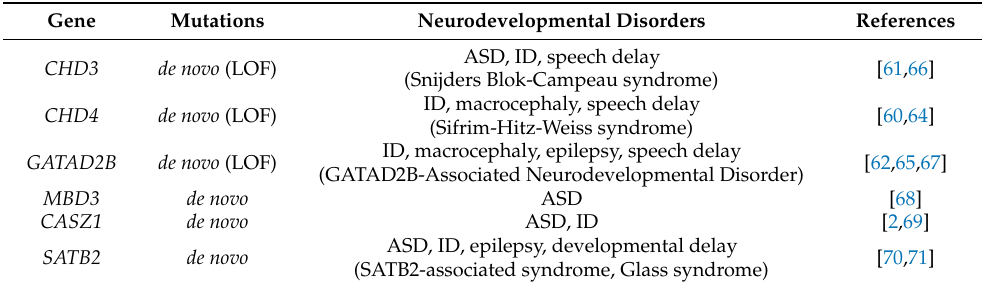
Table 1. NuRD complex genes and neurodevelopmental disorders. Depicted genes are confirmed to interact with NuRD for their neurodevelopmental functions. Gene Mutations Neurodevelopmental